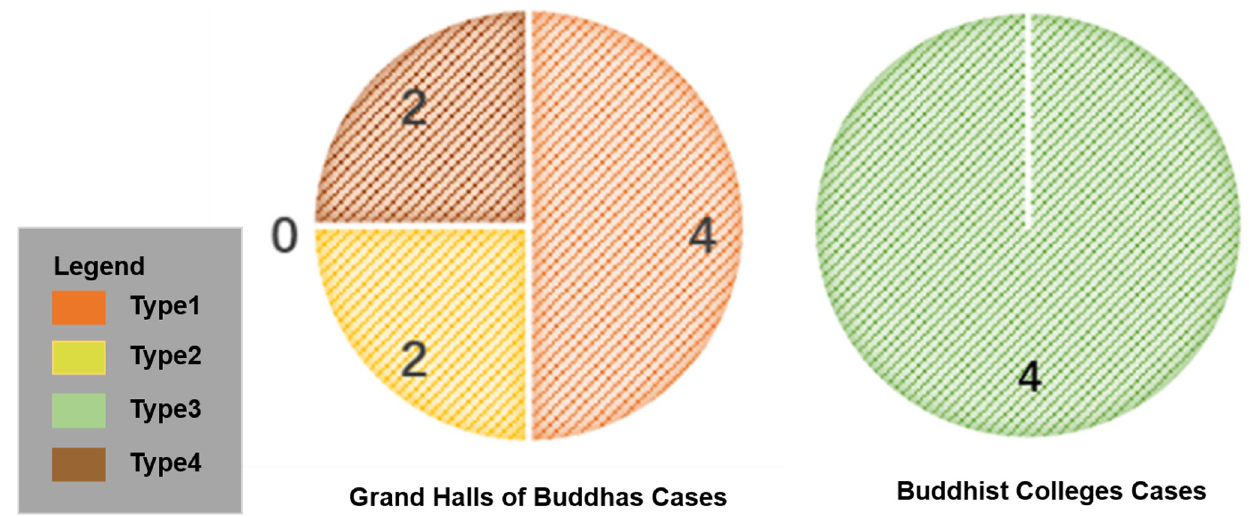
Fig 13. Examples of the four types of palace spaces in the buildings of the grand halls of Buddhas and Buddhist colleges.